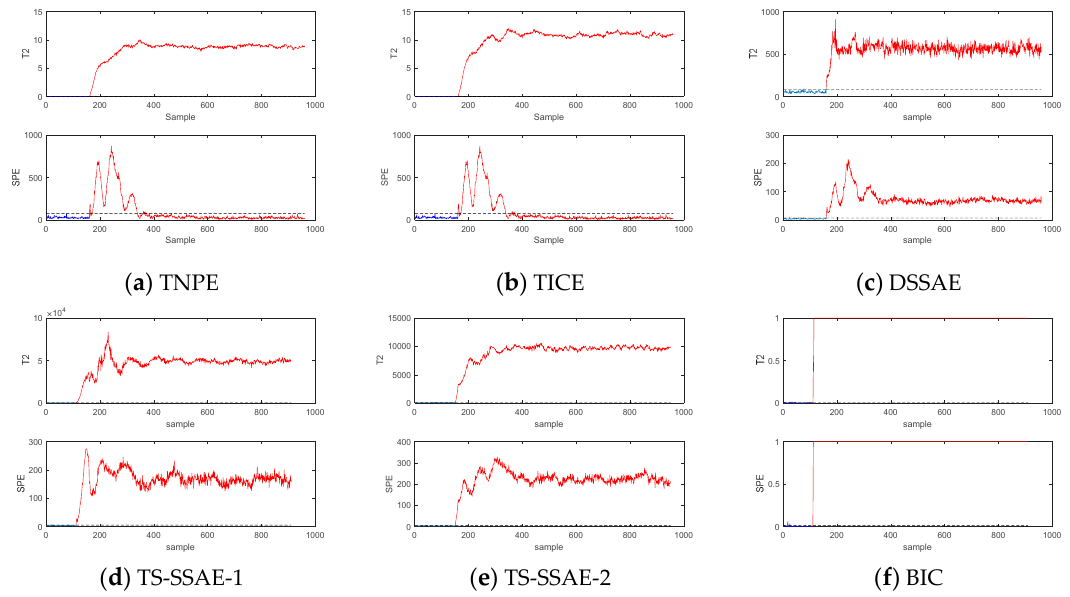
Figure 7. Monitoring results of the Tennessee-Eastman process for fault 5.